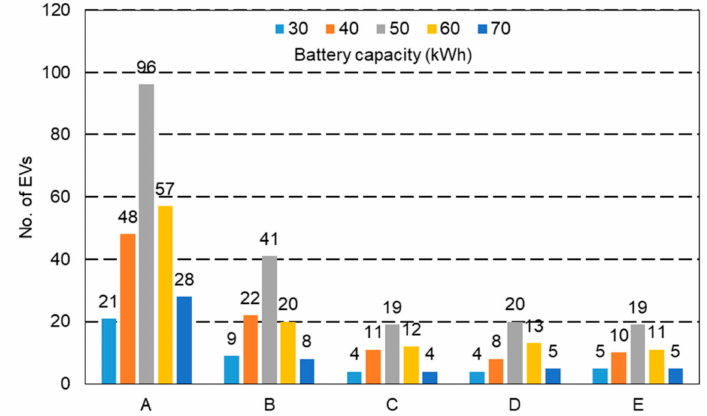
Figure 8. Distribution of different battery capacities in the EVs of each group (Monte Carlo simula- tion